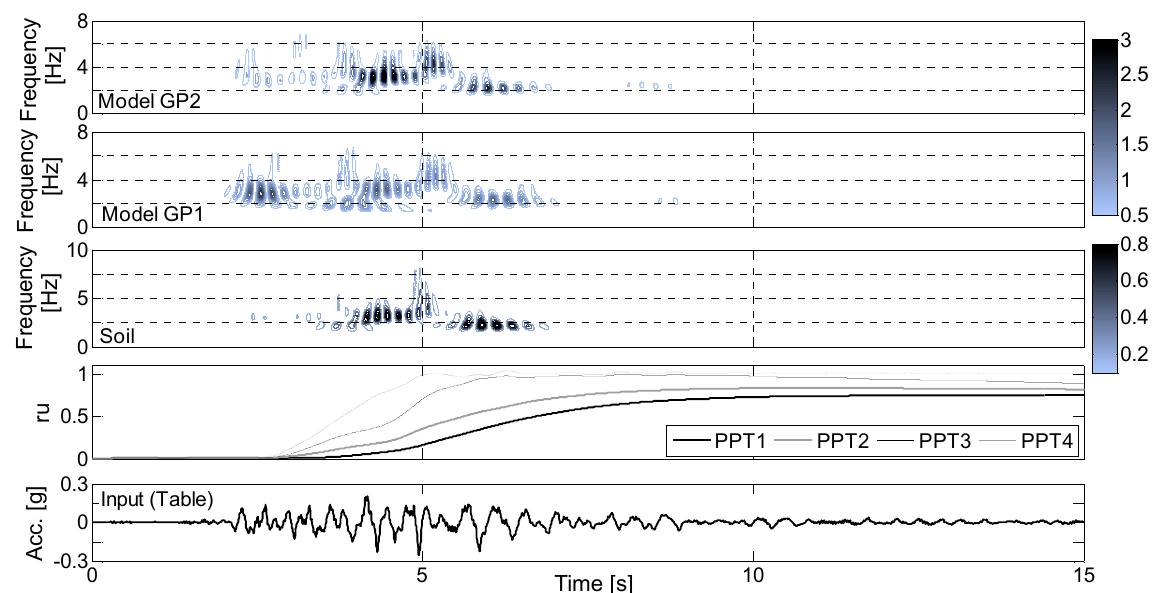
Figure 34. Spectrograms obtained from structural and soil responses. Time histories of input acceleration and excess pore pressure ratios are also given at the bottom of the figure.